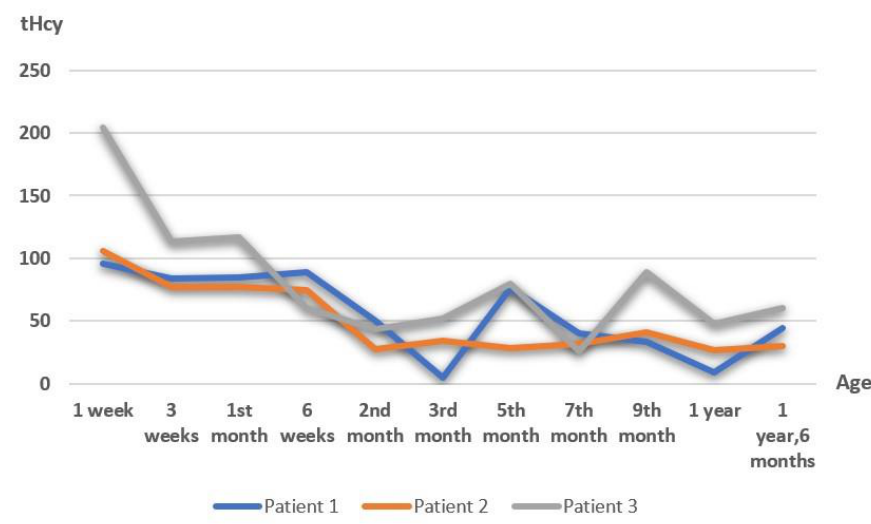
Figure 1. The trend in p-homocysteine. The patient’s age is indicated on the abscissa. Total homocys-